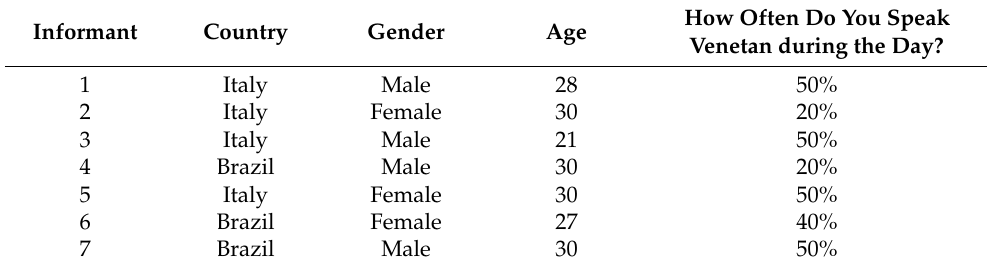
Table 2. Sociolinguistic data of the speakers in Italy and